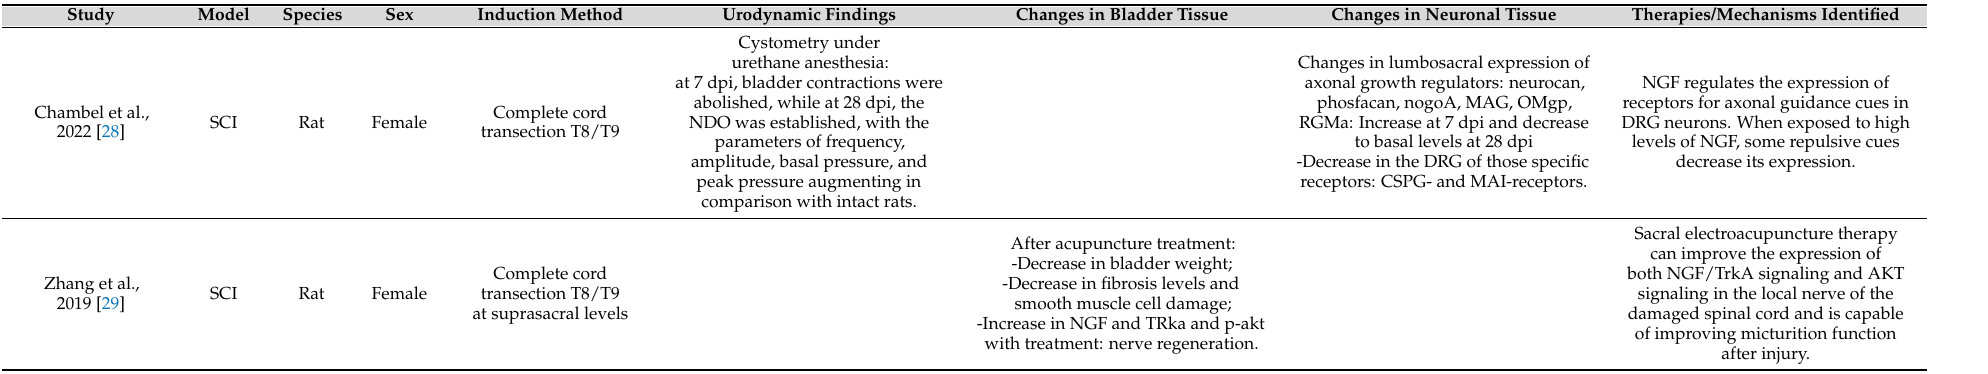
Table 1. Summary of included studies in this systematic review. The data were extracted and sorted into the following categories: model, species, sex, induction method, urodynamic findings, changes in bladder tissue, changes in neuronal tissue, and therapies/mechanisms identified. NDO: neurogenic detrusor overactivity; SCI: spinal cord injury; MAG: myelin-associated glycoprotein; OMpg: outer membrane protein G; RGMa: repulsive guidance molecule A; NGF: nerve growth factor; DRG: dorsal root ganglion; Trka: tropomyosin receptor kinase A; AKT: protein kinase B; TRPM4: transient receptor potential cation channel subfamily member 4; NF200: neurofilament 200; S100: S-100 protein marker; TRPV1: transient receptor potential cation channel subfamily V member 1; M3: muscarinic receptor 3; TGFB1: transforming growth factor beta 1; BoNT-A: botulinum toxin-A; DSD: detrusor sphincter dyssynergia; BDNF: brain-derived neurotrophic factor; ASIC: acid-sensing ion channel; RTX: resiniferatoxin; GAP43: growth-associated protein 43; CGRP: calcitonin gene-related peptide; IPHFO: duration of intra-luminal pressure at high-frequency oscillations; GFAP: glial fibrillary acidic protein; PGE2: prostaglandin E2; HIF: hypoxia-inducible factor; TGF: transforming growth factor; bFGF: basic fibroblast growth factor; NVC: non-voiding contraction; CRF: corticotropin-releasing factor; EUS: external urethral sphincter; PGP. 9.5: protein gene product 9.5; TH: tyrosine hydroxylase; JNK: c-Jun N-terminal kinase; SNAP-25: synaptosomal-associated protein, 25kDa; ATF3: activating transcription factor 3; TRPA1: transient receptor potential cation channel subfamily A member 1; P2X: purinergic receptors; PTNS: percutaneous tibial nerve stimulation; 5-HT: 5-hydroxytryptamine; VGLUT2: vesicular glutamate transporter 2; GABA: gamma-aminobutyric acid; GAD2: glutamate decarboxylase 2; KV1.4: potassium channel Kv1.4; CD11: integrin beta chain-2; SMA: smooth muscle actin; ki67: antigen KI-67; TUNNEL: terminal deoxynucleotidyl transferase dUTP nick end labeling; ICC: interstitial cells of Cajal; PAG: periaqueductal gray; PMC: pontine micturition center; GAPDH: Glyceraldehyde-3-Phosphate dehydrogenase; TGN: tissue gene nerve; VEGF: vascular endothelial growth factor; iNOS: nitric oxide synthase; VTA: ventral tegmental area; IFN: interferon; MBP: myelin basic protein; CTGF: connective tissue growth factor; TGF: transforming growth factor; EAE: experimental autoimmune encephalomyelitis; CNS: central nervous system; IL-B: interleukin beta; CIE: coronavirus-induced encephalitis; MS: multiple sclerosis; Panx1: pannexin 1; cx34: gap junction alpha-1 Protein; SCF: Skp1-cullin 1-F-box; EP2/3: prostaglandin receptors; MCAO: experimental middle cerebral artery occlusion; PD: Parkinson ´ s disease; 6-OHDA: 6-hydroxydopamine;